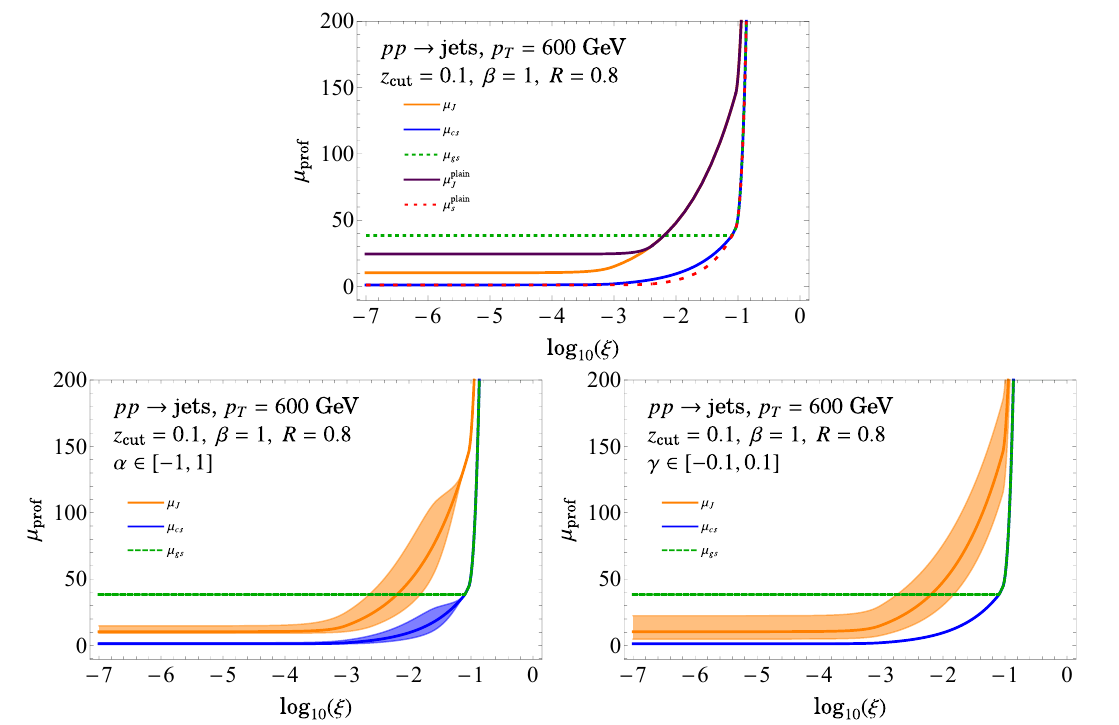
Figure 4 . Profile functions for pp collisions at p T = 600 GeV. Top panel shows profiles used for the soft-drop resummed and plain jet-mass cross sections. The bottom panel shows the profile variations with α (left panel) and with γ (right panel) in the soft-drop resummation